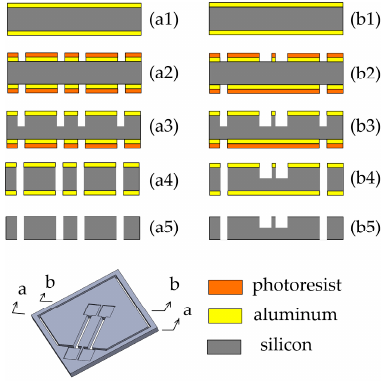
Figure 9. The schematic of the main fabrication process of silicon substrate; (1) Deposit aluminum layers; (2) Photoetching and Etching the aluminum layers; (3) Etching the silicon from the front side; (4) Etching the silicon from the back side; (5) Removing the aluminum layers.